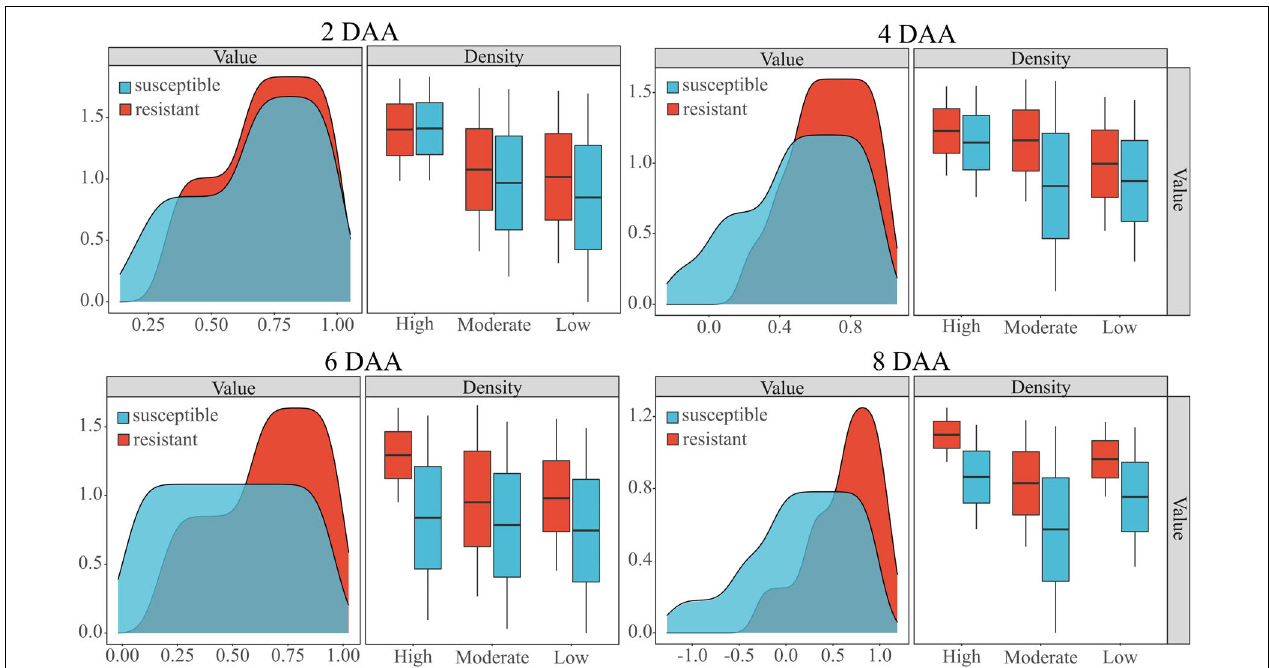
FIGURE 7 | Classification of susceptible and resistant barnyardgrass biotypes at different densities (high, moderate, low) by the WSRI. DAA is days after application.